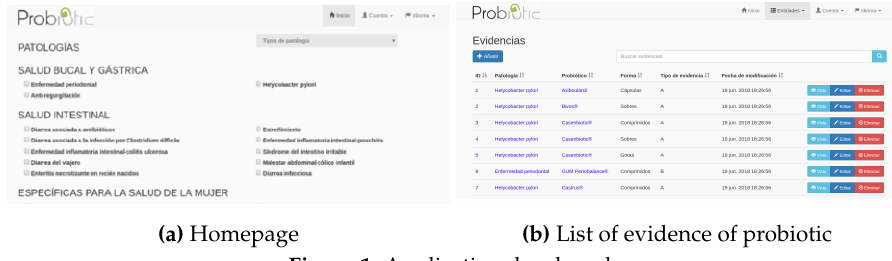
Figure 1. Application